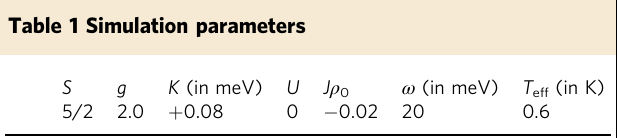
Parameters used for all simulations of experimental data shown in this